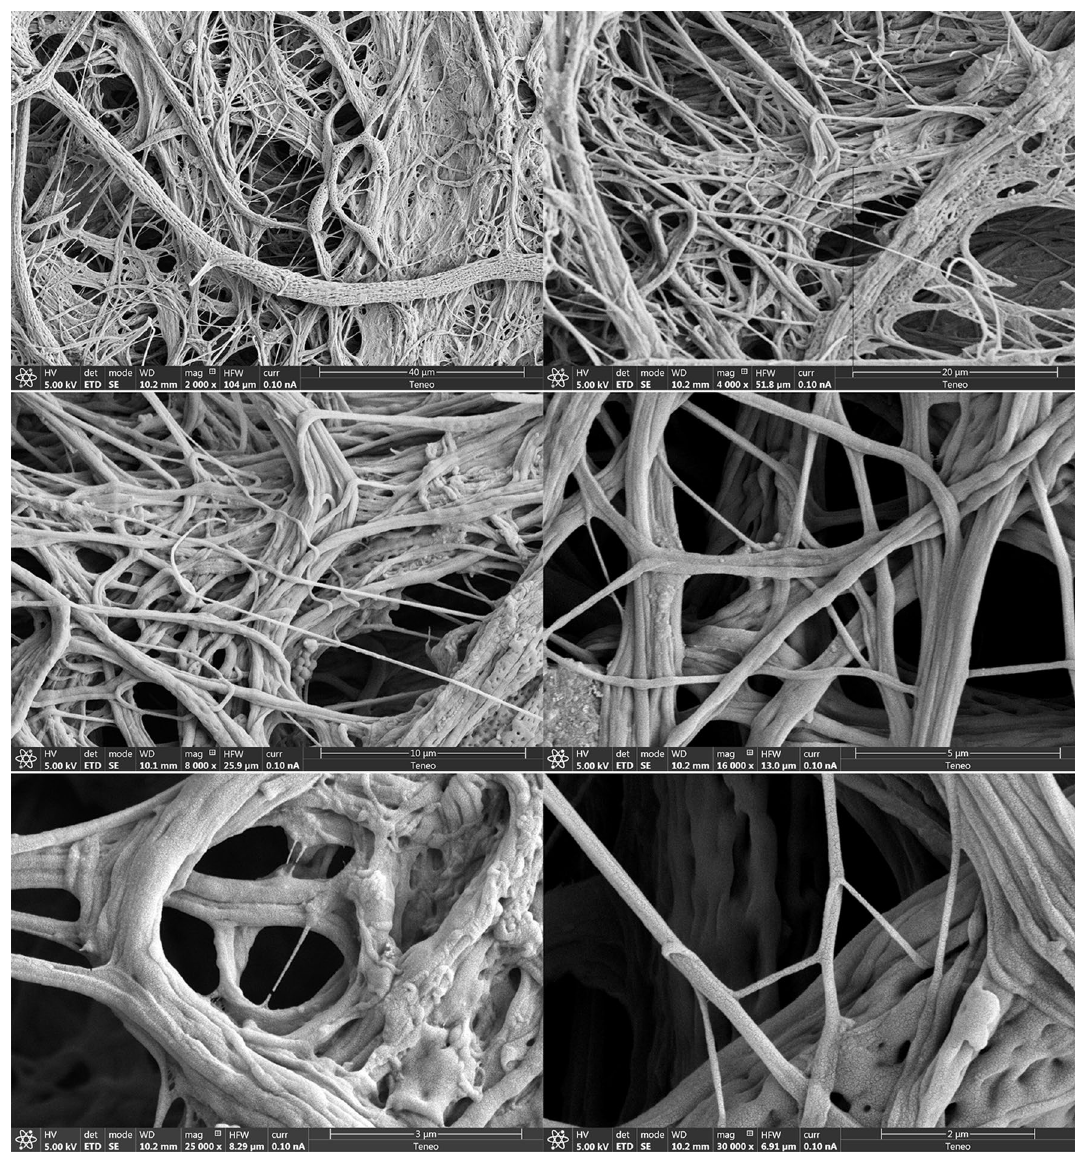
Figure 2. Different examples of the fibrous structure used to measure fiber diameters and lengths, for five zoom-in